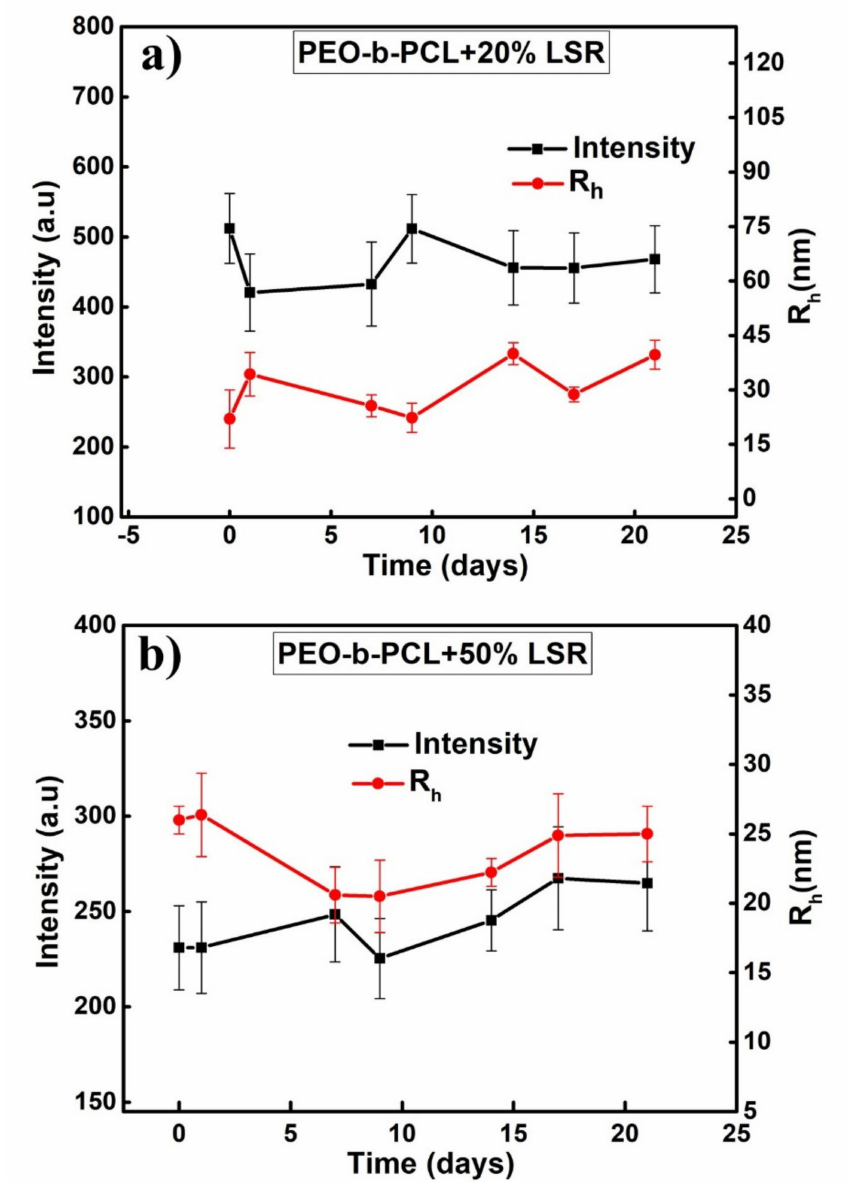
Figure 5. Scattered intensity and R h measurements versus time obtained from DLS of ( a ) PEO-b-PCL + 20% LSR and ( b ) PEO-b-PCL + 50% LSR nanocarriers in aqueous